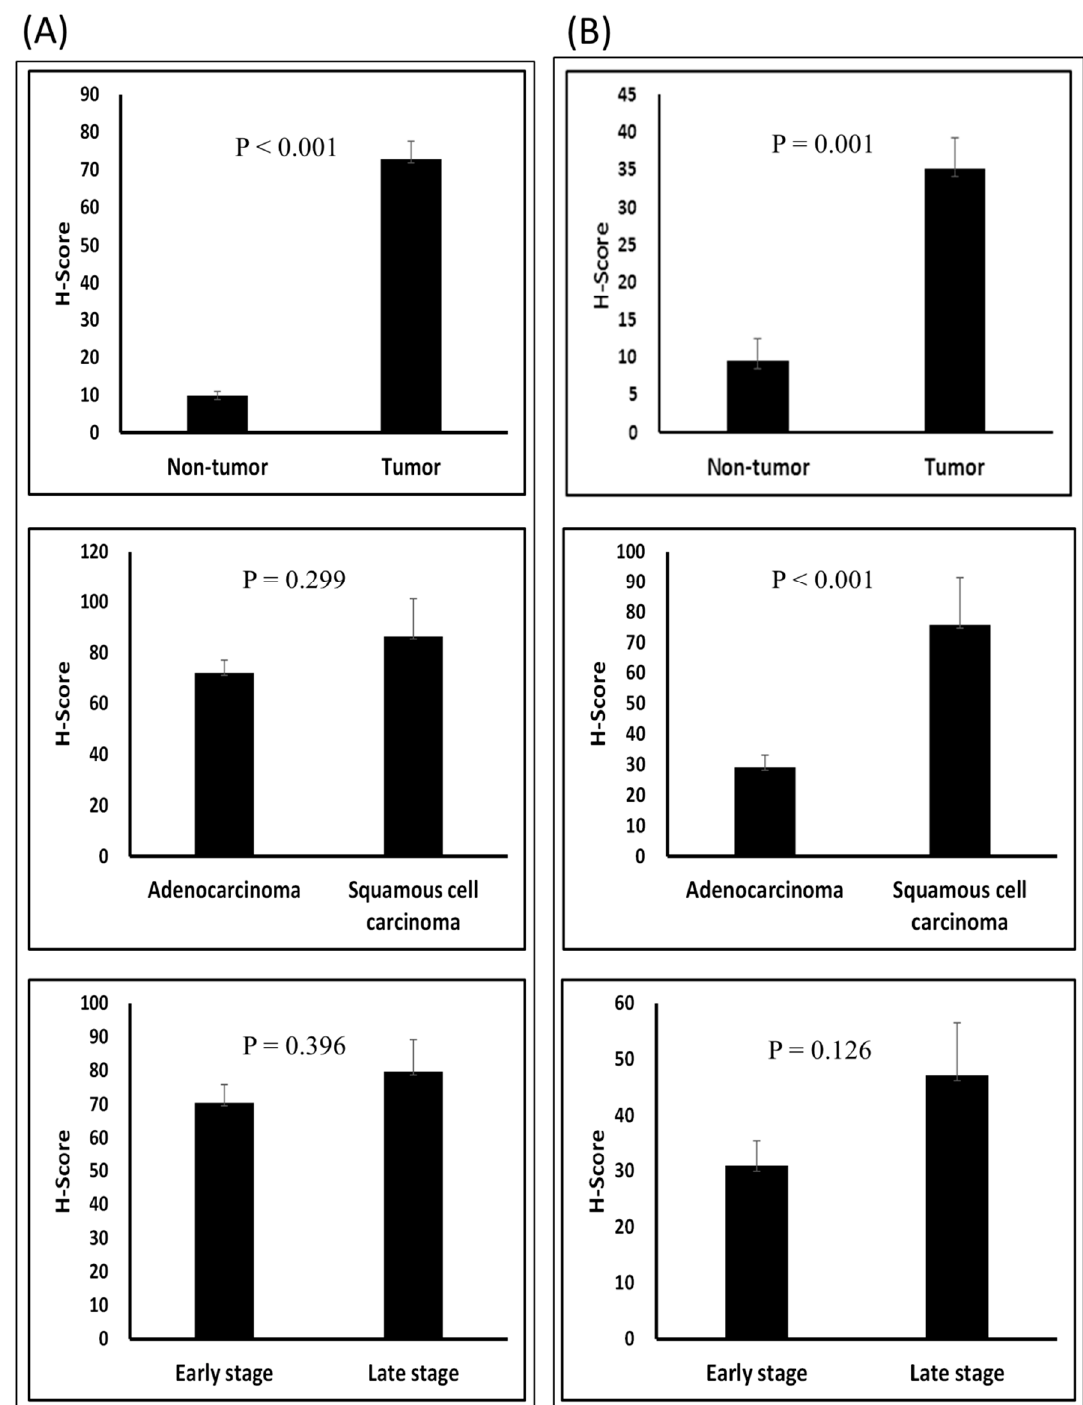
Figure 5. T-test of the H-score in different groups: ( A ) CAR and ( B ) DSG2 in tumor vs. normal tissue; adenocarcinoma vs. squamous cell carcinoma; and early stage vs. late stage.